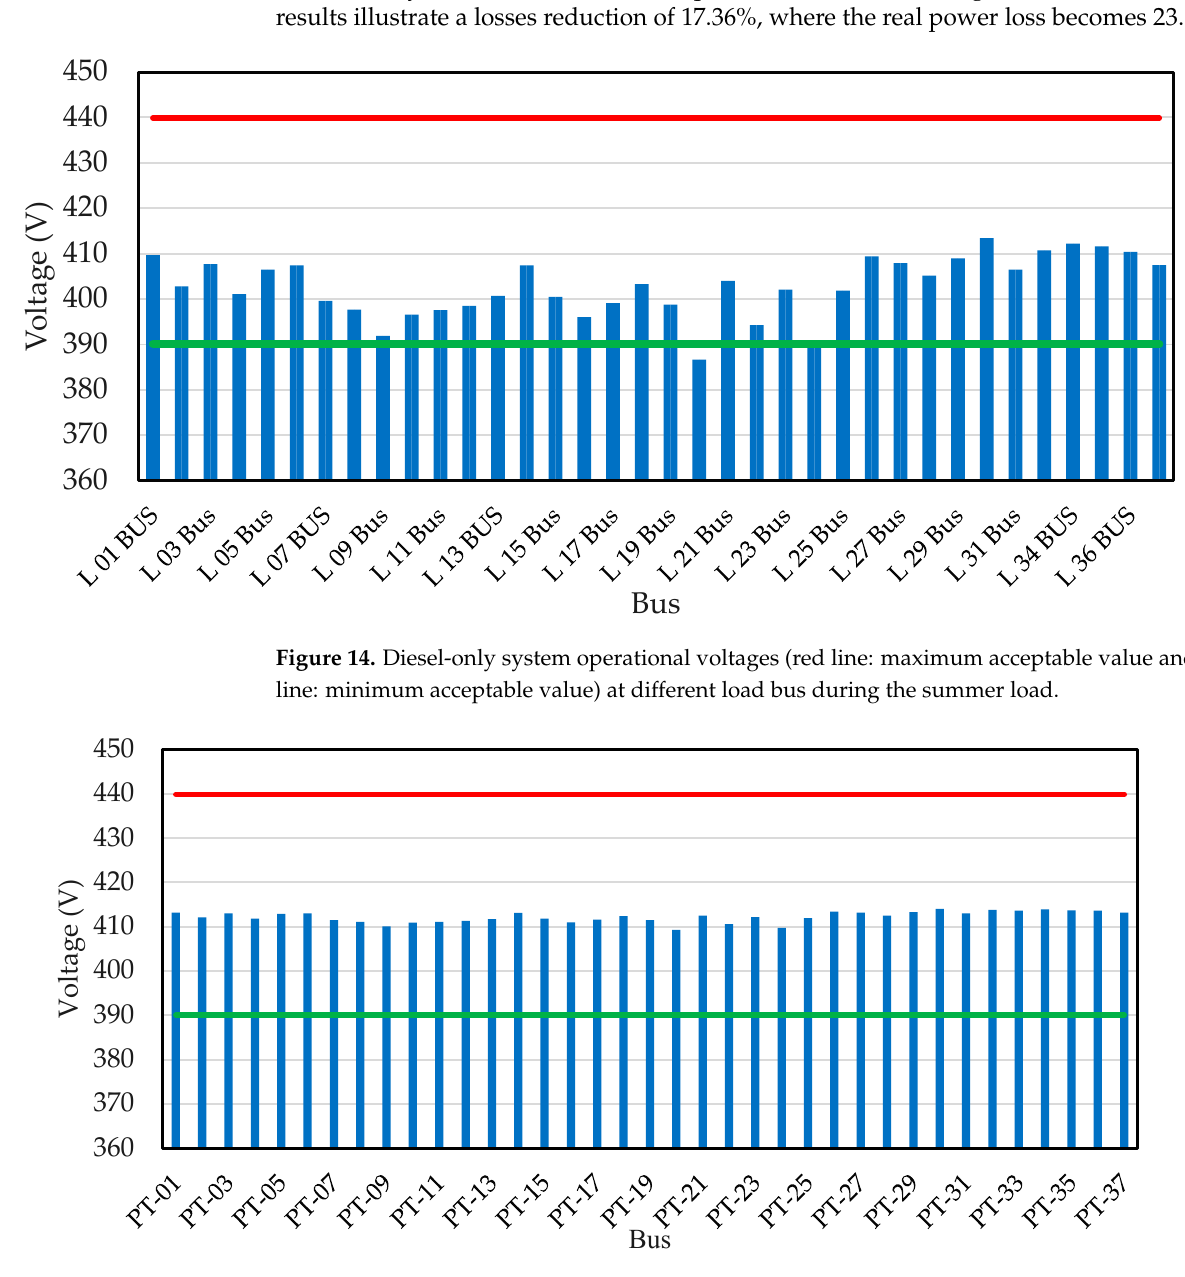
Figure 15. Diesel-only system operational voltage (red line: maximum acceptable value and green line: minimum acceptable value) at different load bus during the winter load. Table 13. Generated power and total losses in the PV–wind–diesel system during